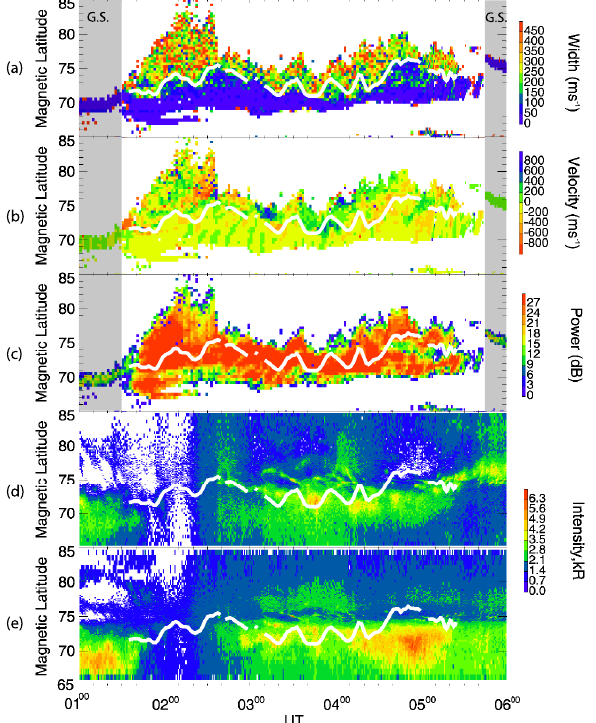
Fig. 3. HF radar data from CUTLASS Finland beam 9, 20 De- cember 1998, (a) Doppler spectral width, (b) line-of-sight velocity (blue is towards the radar), (c) backscatter power. MSP data from Longyearbyen, (d) 630.0nm, red emission, from an assumed al- titude of 250km, (e) 557.7nm, green emission, from an assumed altitude of 110km. All 5 panels have the spectral width gradient at 200m/s overlaid on them in white for comparison. The intervals marked “G.S” have been identified as ground scatter.